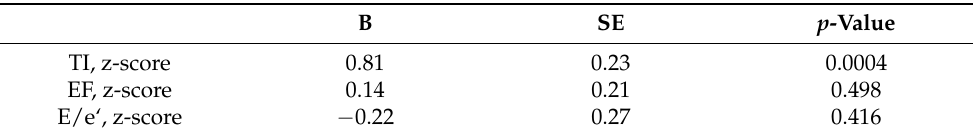
Table 3. Binary logistic regression analysis of echocardiographic parameters for presence of my- ocarditis in the total cohort before propensity weighting. Abbreviations: B = regression coefficient, EF = ejection fraction, SE = standard error, TI = Tei